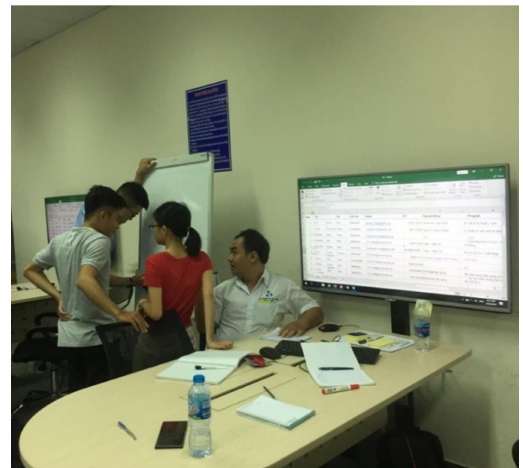
Figure 28. Moment of team discussion.